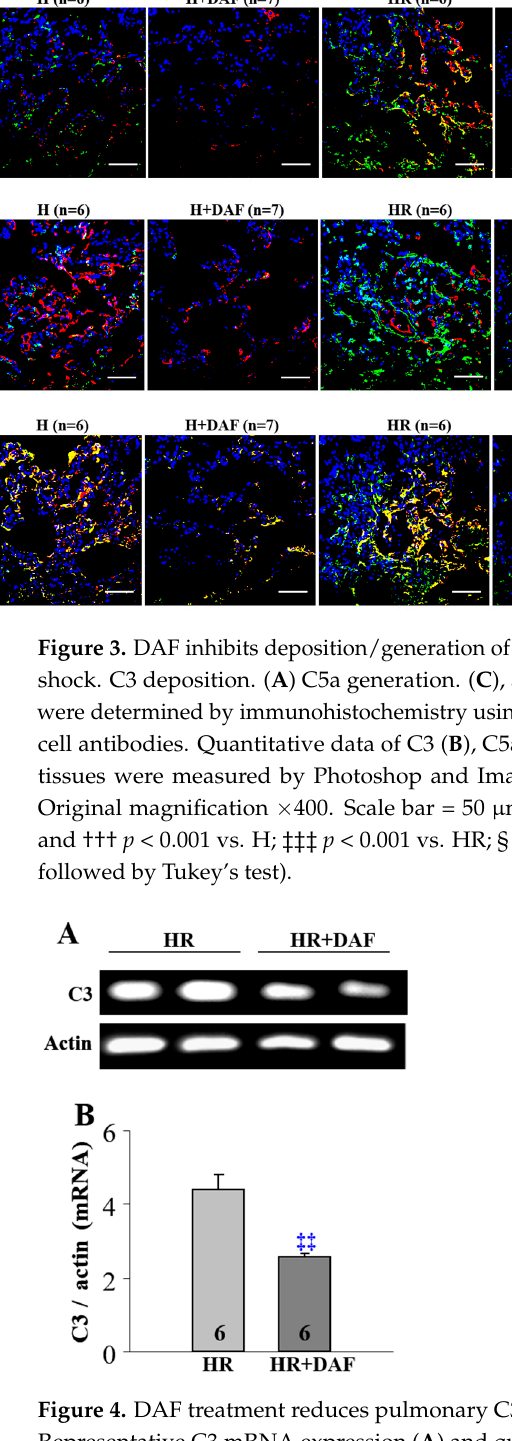
Figure 4. DAF treatment reduces pulmonary C3 mRNA synthesis in rats with hemorrhagic shock. Representative C3 mRNA expression ( A ) and quantitative expression of C3 mRNA ( B ) in the lungs. The number (6) in the figure marks the number of samples. ‡‡ p < 0.01 vs. HR (unpaired t ‒ test with Welch’s correction).